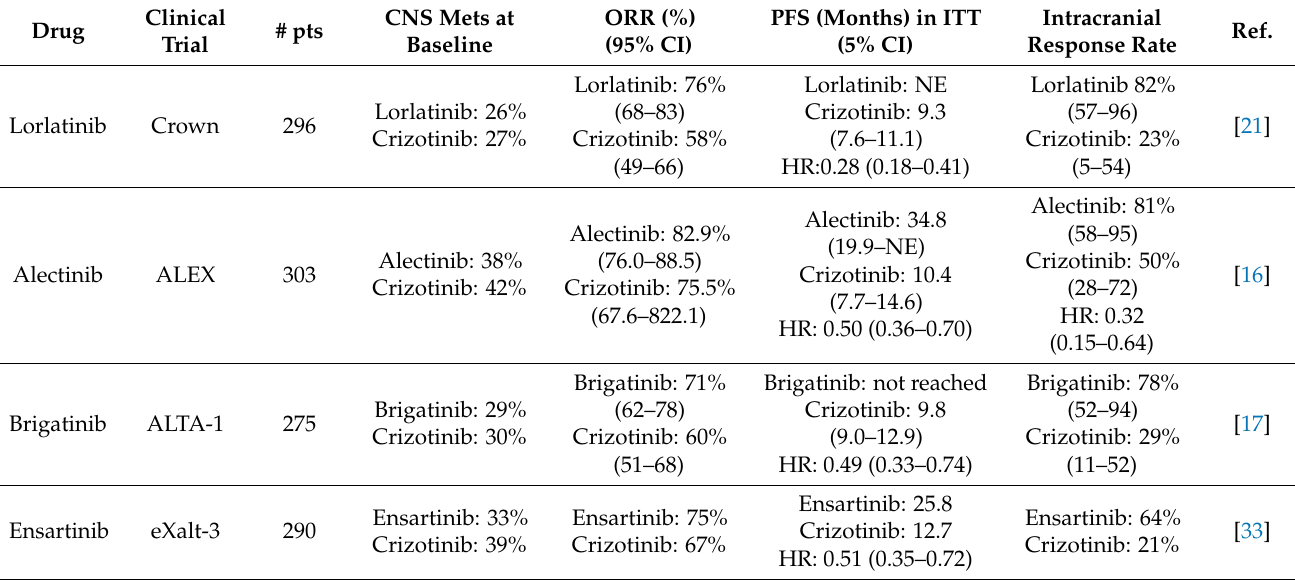
Table 1. Updated efficacy data of next-generation ALK TKIs trials versus